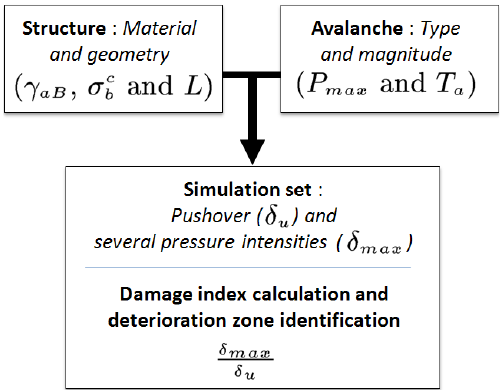
Fig. 15. Methodology to obtain vulnerability curves for concrete structures.